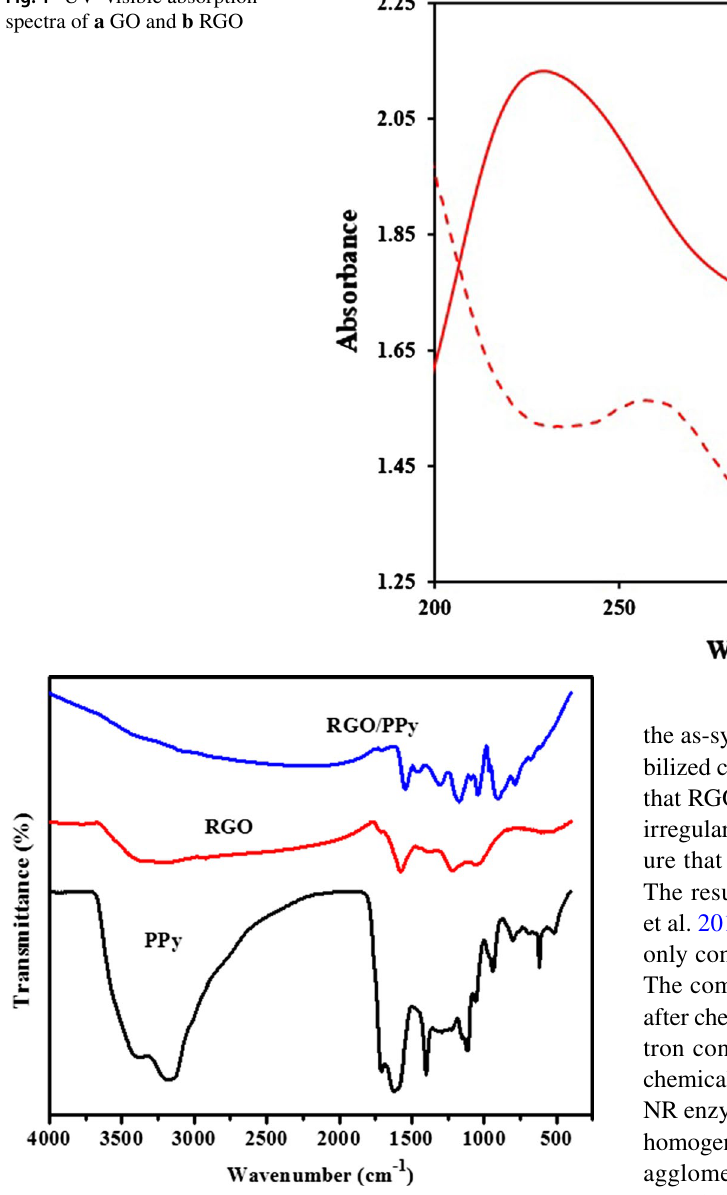
Fig. 2 FTIR spectra of RGO, PPy and RGO/PPy